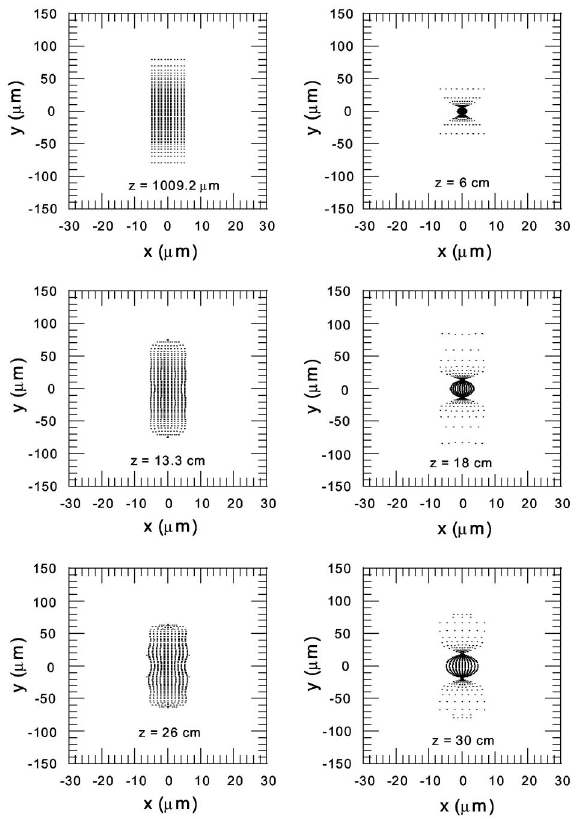
FIG. 14. Drive bunch test particle distribution at z (cid:3) 1009 : 2 (cid:4) m , 6 cm, 13.3 cm, 18 cm, 26 cm, and 30 cm. The test particles are initially where the tenth drive bunch would be, preceded by nine actual rigid drive bunches. The initial dis- tribution extends from x (cid:3) (cid:6) 5 : 0 to 5 : 0 (cid:4) m uniformly and from y (cid:3) (cid:6) 79 : 6 to 79 : 6 (cid:4) m Gaussianly. The F F focusing can be easily identified from the z (cid:3) 6 cm distri- y bution, and the distribution experiences focusing and defocus- ing